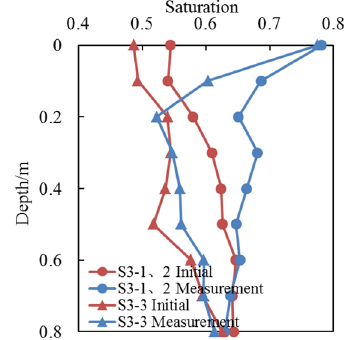
Figure 9. Comparison of measured saturation.